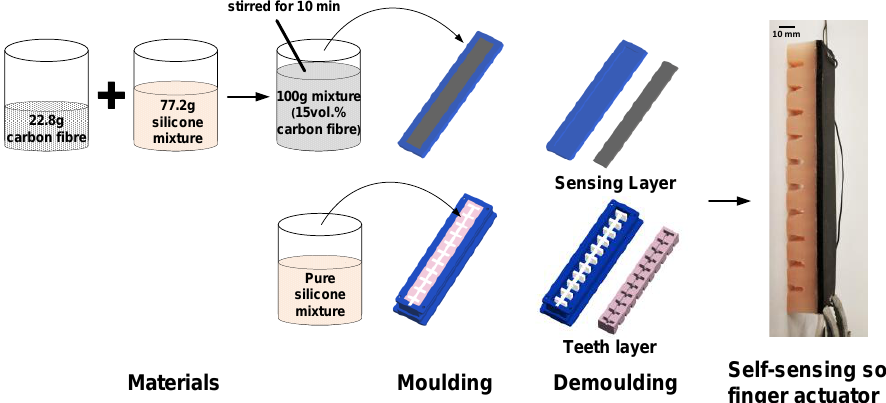
Figure 2. Fabrication of a soft self-sensing finger actuator; finger dimension: 129 mm × 18 mm × 17.5 mm; Carbon sensing layer dimension: 129 mm × 18 mm × 2.8 mm.